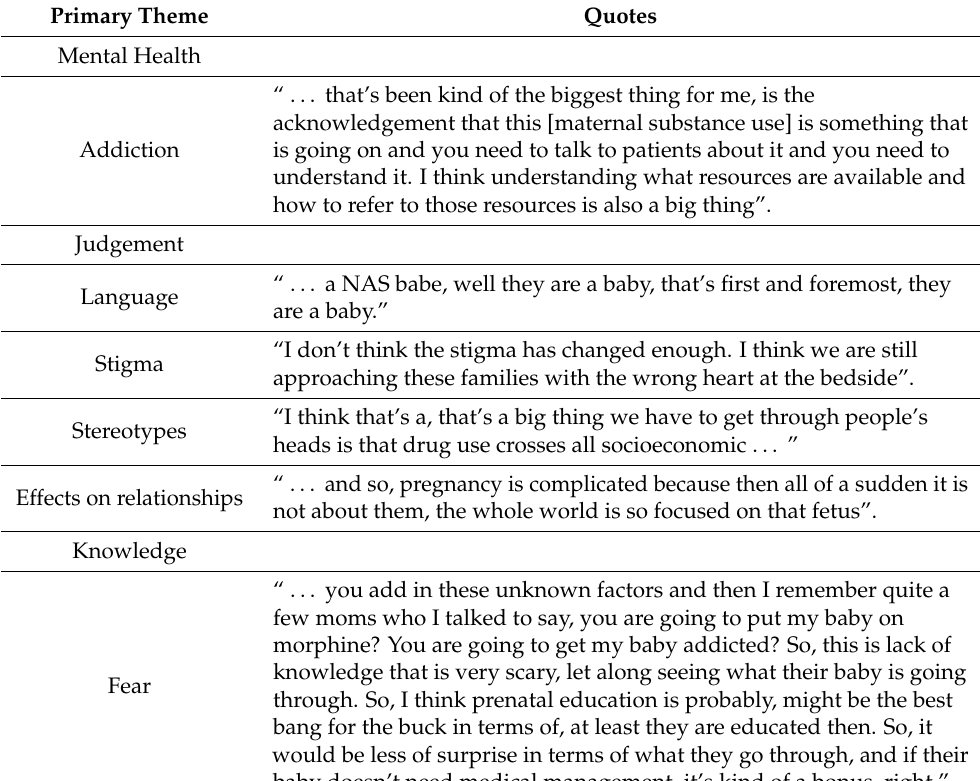
Table 3. Barriers to